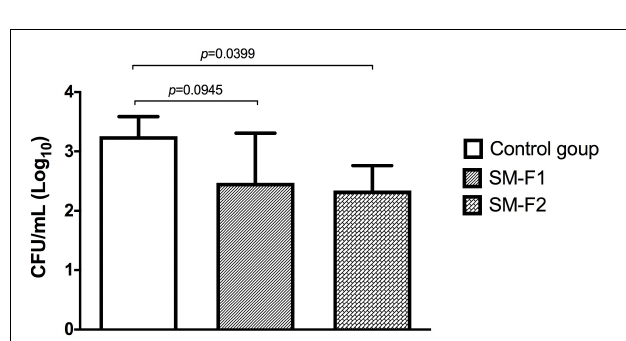
FIGURE 6 | Quantification of Candida cells recovered from the oral cavity of mice. Mean and SD of the CFU/mL (Log) of C. albicans obtained in the non-treated control group (PBS) and the experimental groups treated with the SM-F1 or SM-F2 fractions (1 g/Kg). ANOVA and Tukey